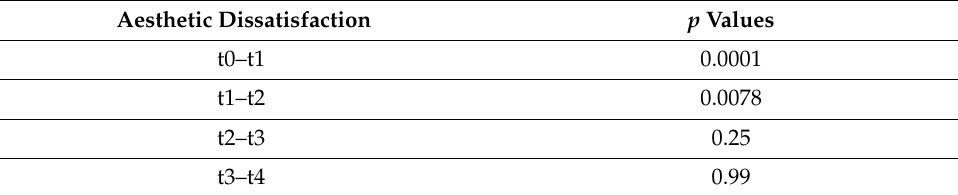
Table 4. Wilcoxon signed-rank